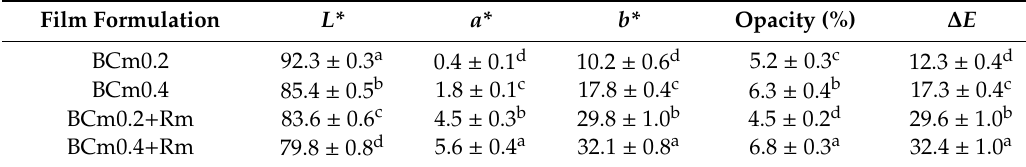
Table 4. Color parameters of BCm-based